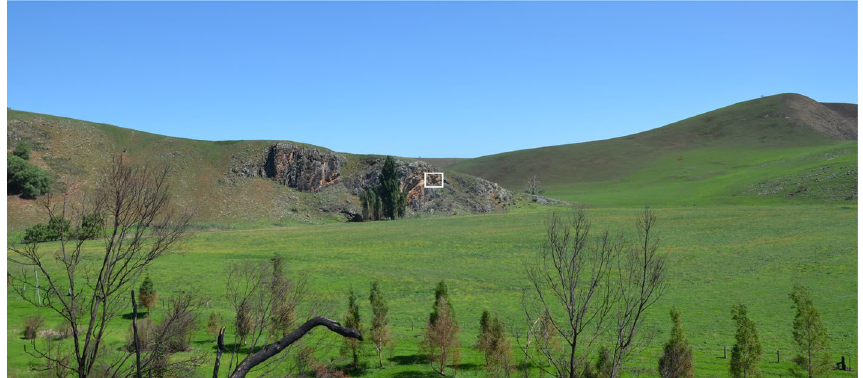
Figure 3. Cloggs Cave cliffline above the Buchan River flood plain, showing location of cave entrance (white rectangle) (photo: Bruno David).